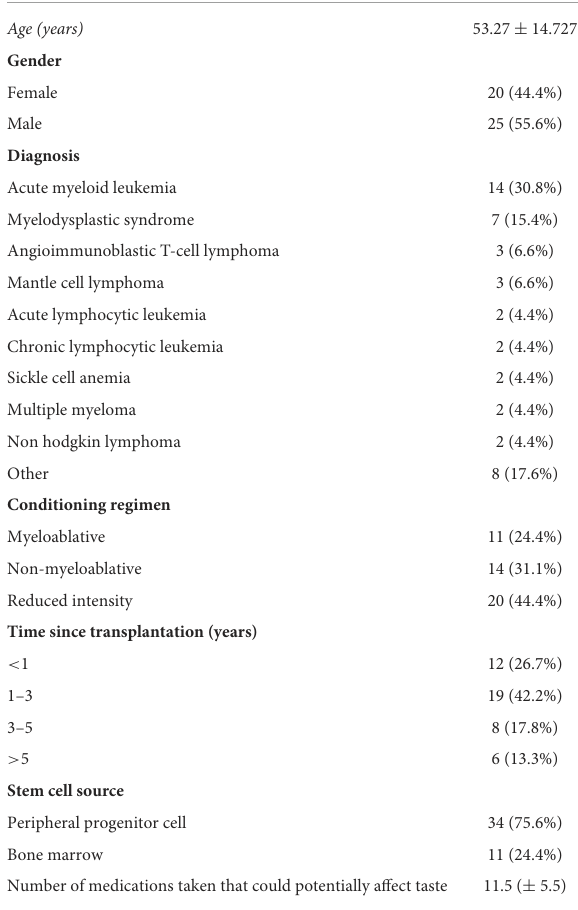
TABLE 1 Patient and treatment